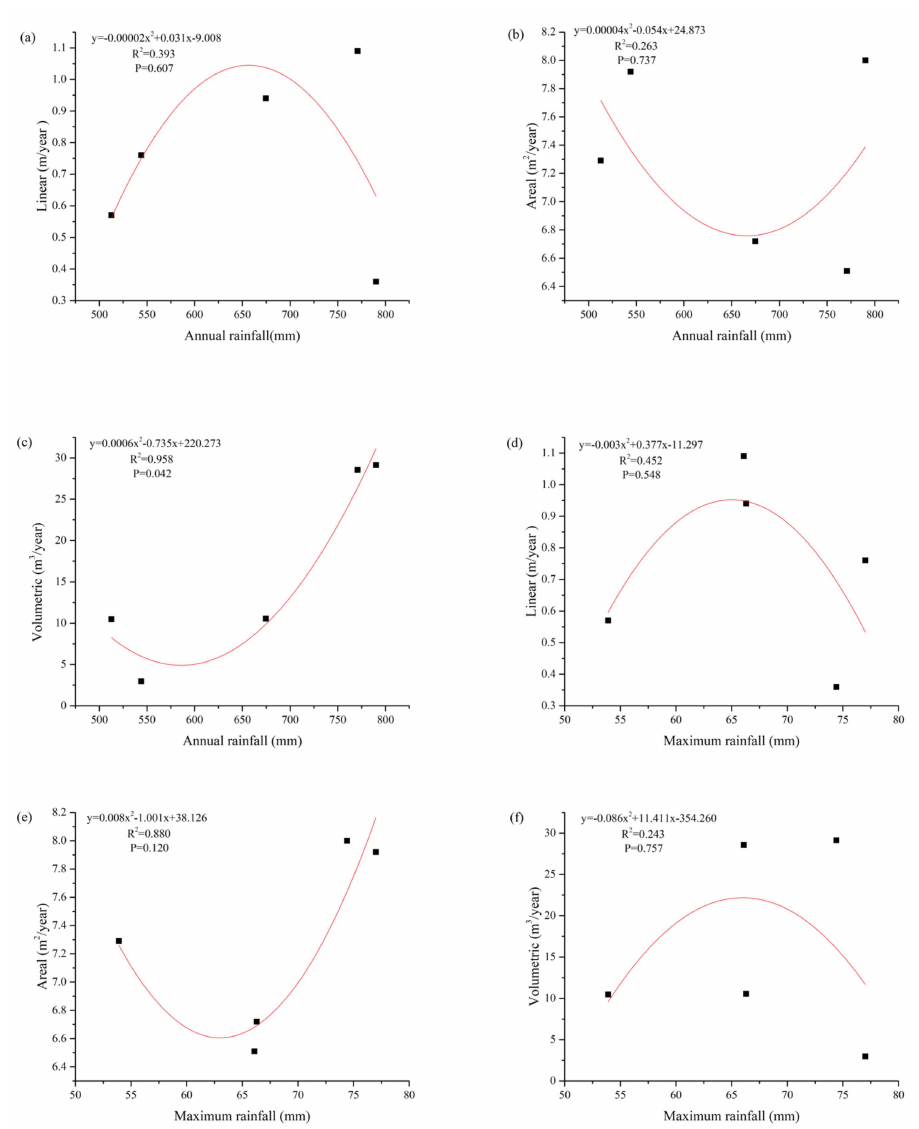
Figure 15. Parabolic relationships between annual and maximum rainfall and annual gully headcut: ( a , d ) linear, ( b , e ) areal, and ( c , f ) volumetric retreat